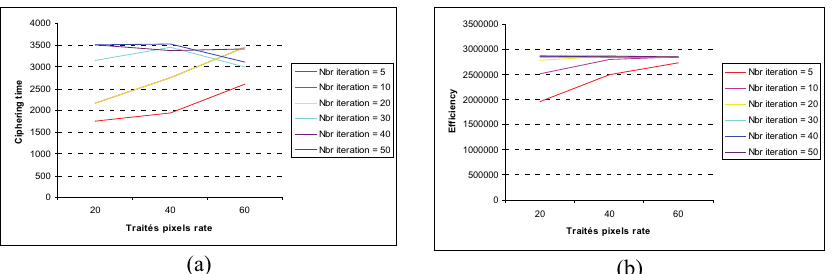
Fig. 9. (a) Variation of ciphering time per iteration according to treated pixels rate, (b) variation of efficiency per iteration according to treated pixels